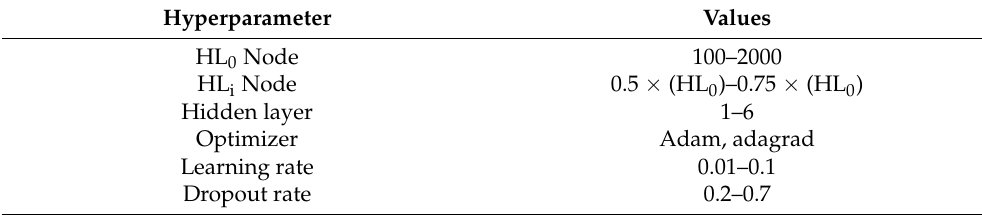
Table 1. The hyperparameter search